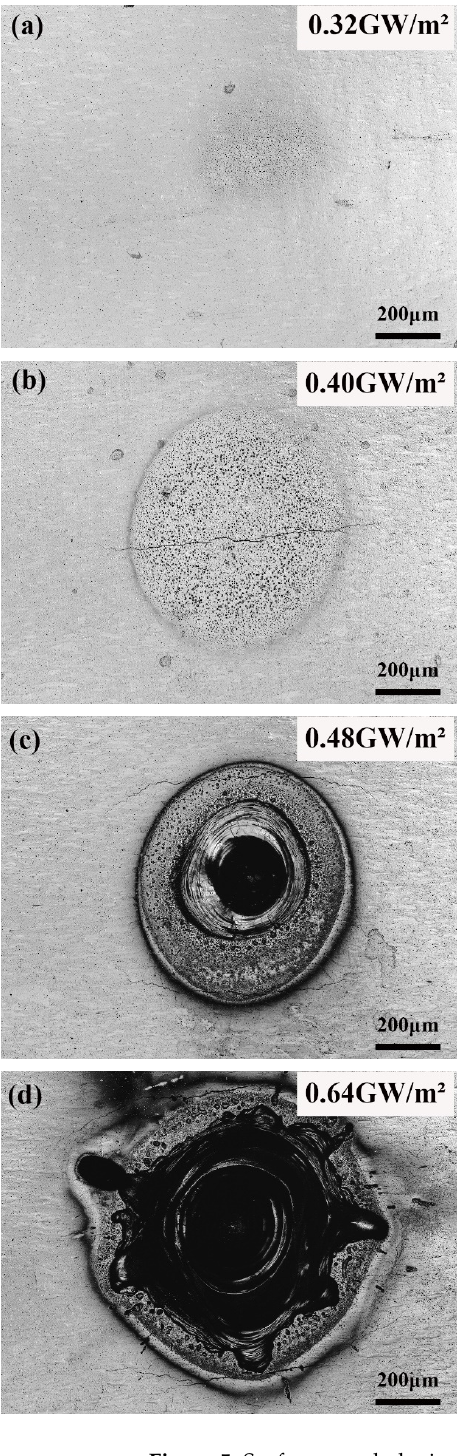
Figure 5. Surface morphologies of WY50 samples under different laser thermal shock power densities: rolled samples ( a – d ); fully recrystallized samples ( e – h